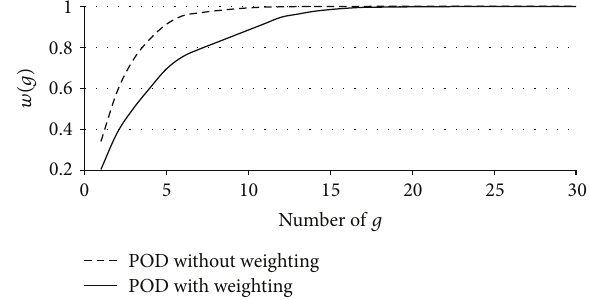
Figure 5: Trial vector derivatives.